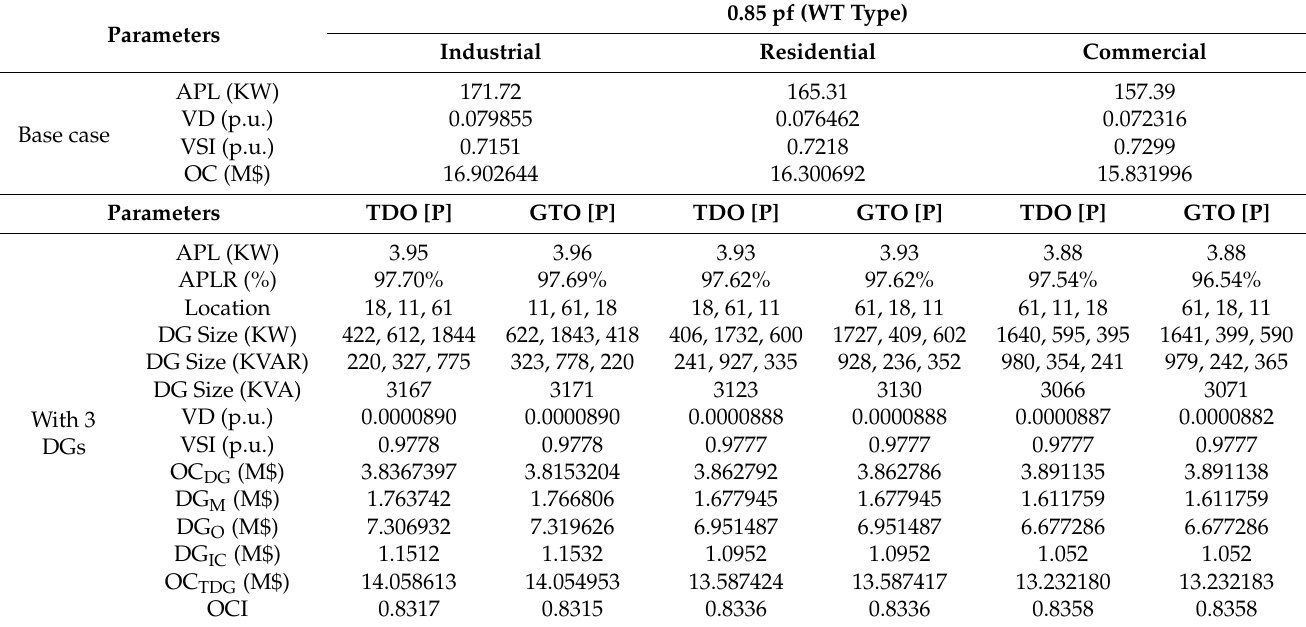
Table 17. Results of the OADG for a 69-bus RDN for MOF at 0.85 pf (WT type) in the VP load